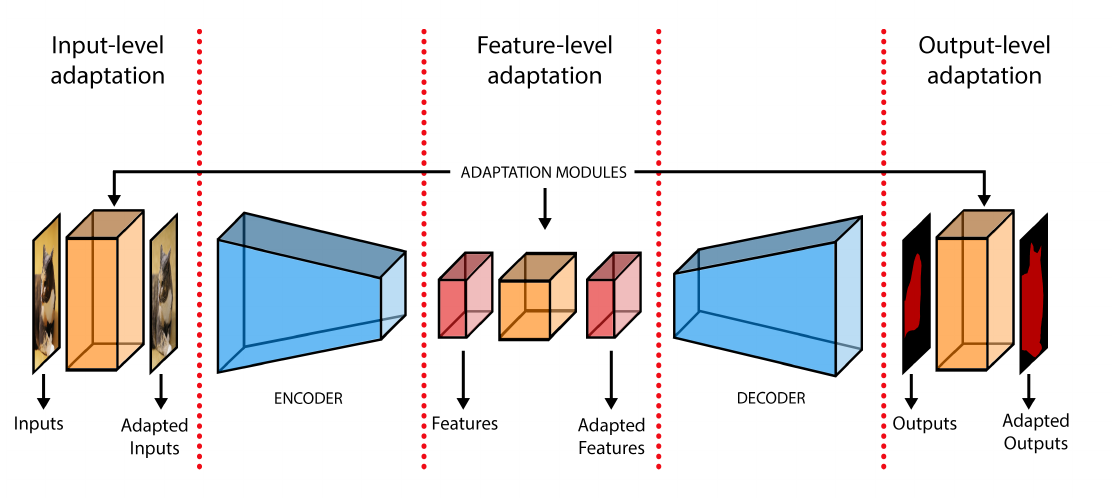
Figure 5. Domain shift adaptation could be performed at different spaces: input-level, feature-level and